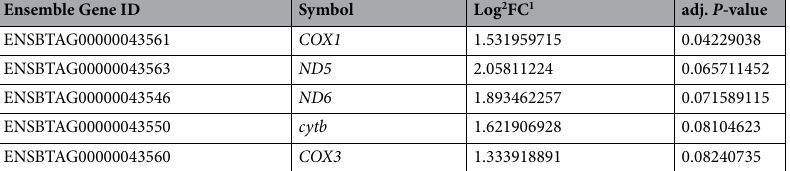
Table 2. Differentially expressed genes in the skeletal muscle of heifers divergent for RFI. 1 Log 2 Fold change was calculated for each gene from the expression value of low-RFI compared to high-RFI.